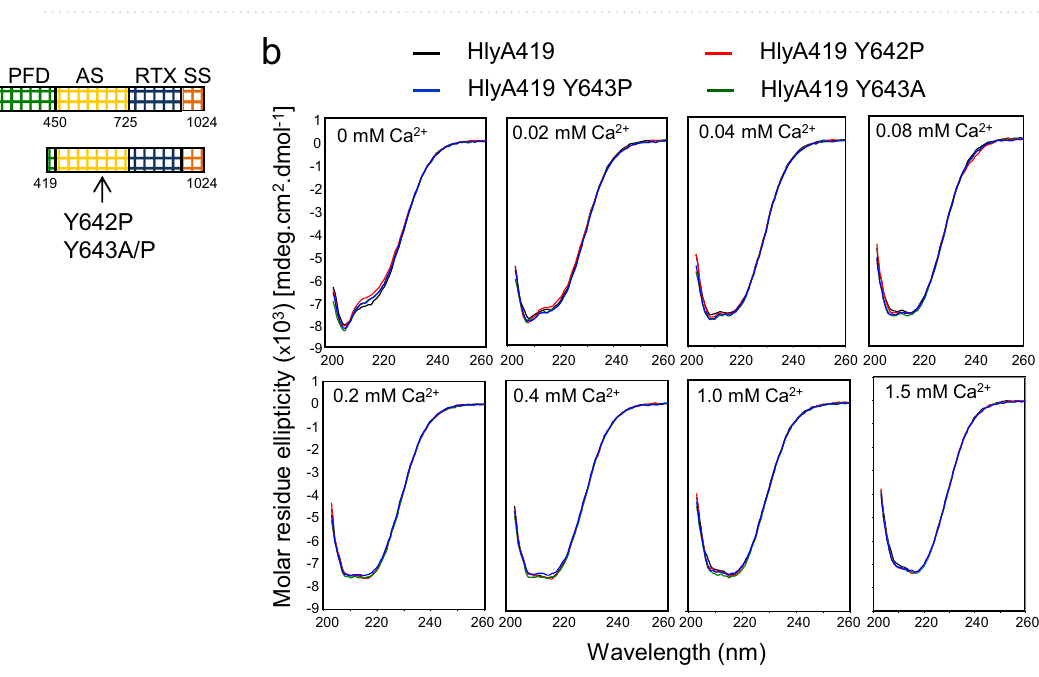
Figure 6. Substitution of the tyrosine of the acylated segment did not affect the formation of secondary structures of the HlyA419 ( a ) Schematic representation of the HlyA and HlyA-derived HlyA419. PFD, pore- forming domain; AS, acylated segment; RTX, calcium-binding repeats; SS, secretion signal. ( b ) Far-UV CD spectra of the HlyA419, HlyA419 Y642P, HlyA419 Y643P and HlyA419 Y643A proteins (200 μg/ml) in the absence and the presence of CaCl 2 . The data correspond to the average of two independent experiments with 3 accumulations per